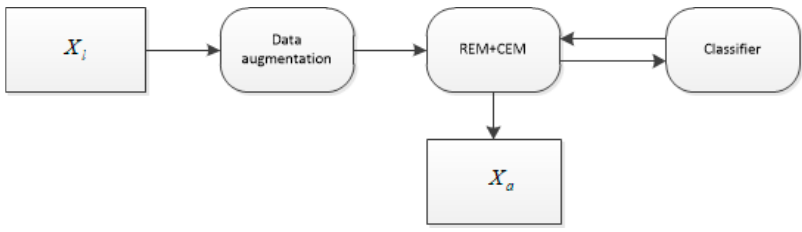
Figure 3. The illustration of the EPiDA data augmentation module.